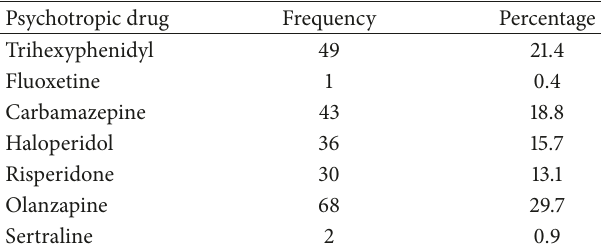
Table 5: Psychotropic drugs prescribed to patients who performed above the cut-off for the MMSE.